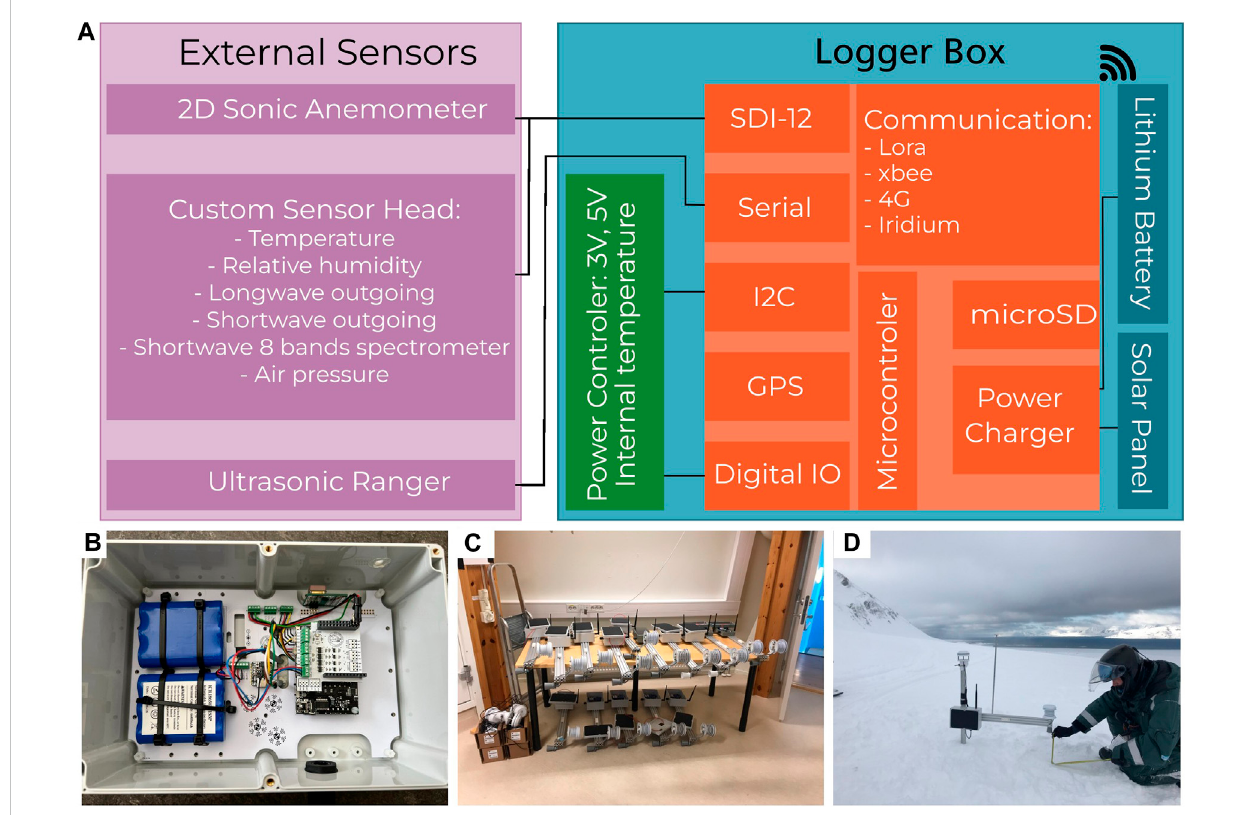
FIGURE 3 (A) Hardware diagram of one node. A node consists of a main logging box (blue) with inside a set of devices all managed by the main board (orange box), and a set of sensors either commercial or custom made (purple). Photos of the inside of the logger box (B) , preparation prior to deployment of the nodes (C) , and a node deployed (D) .